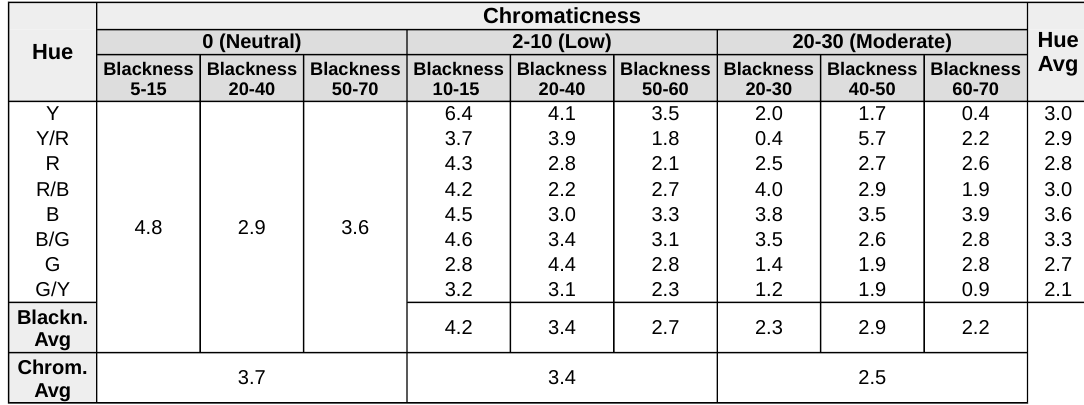
Table A3. Colour differences ∆ E between colour-calibrated images and colorimetric values of 51 representative colours from the NCS exterior set to verify the image capture and colour calibration workflow. The colours are grouped according to chromaticness, blackness, and hue. See Figure 4 for a sample capture containing some of these